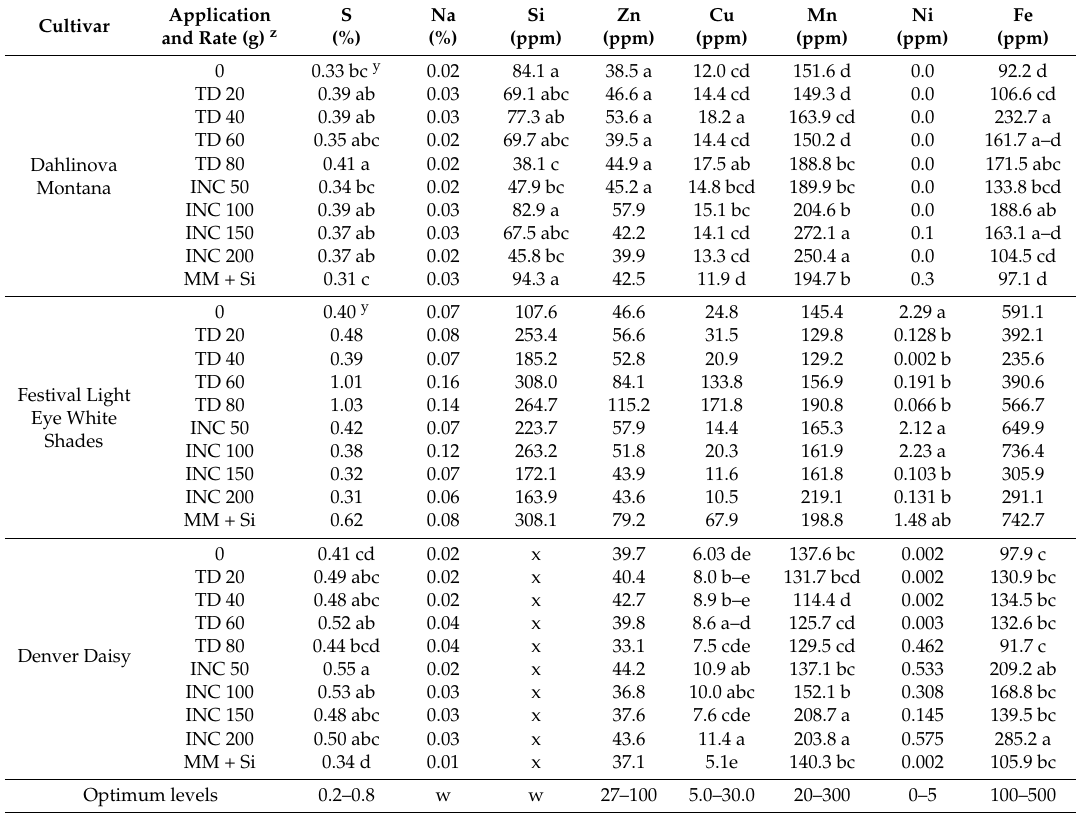
Table 6. Leaf micronutrient and trace element content affected by diatomaceous earth treatment across irrigation, controlled by a tensiometer, in Dahlia × hybrida ‘Dahlinova Montana’, Gerbera jamesonii ‘Festival Light Eye White Shades’, and Rudbeckia hirta ‘Denver Daisy’. Cultivar